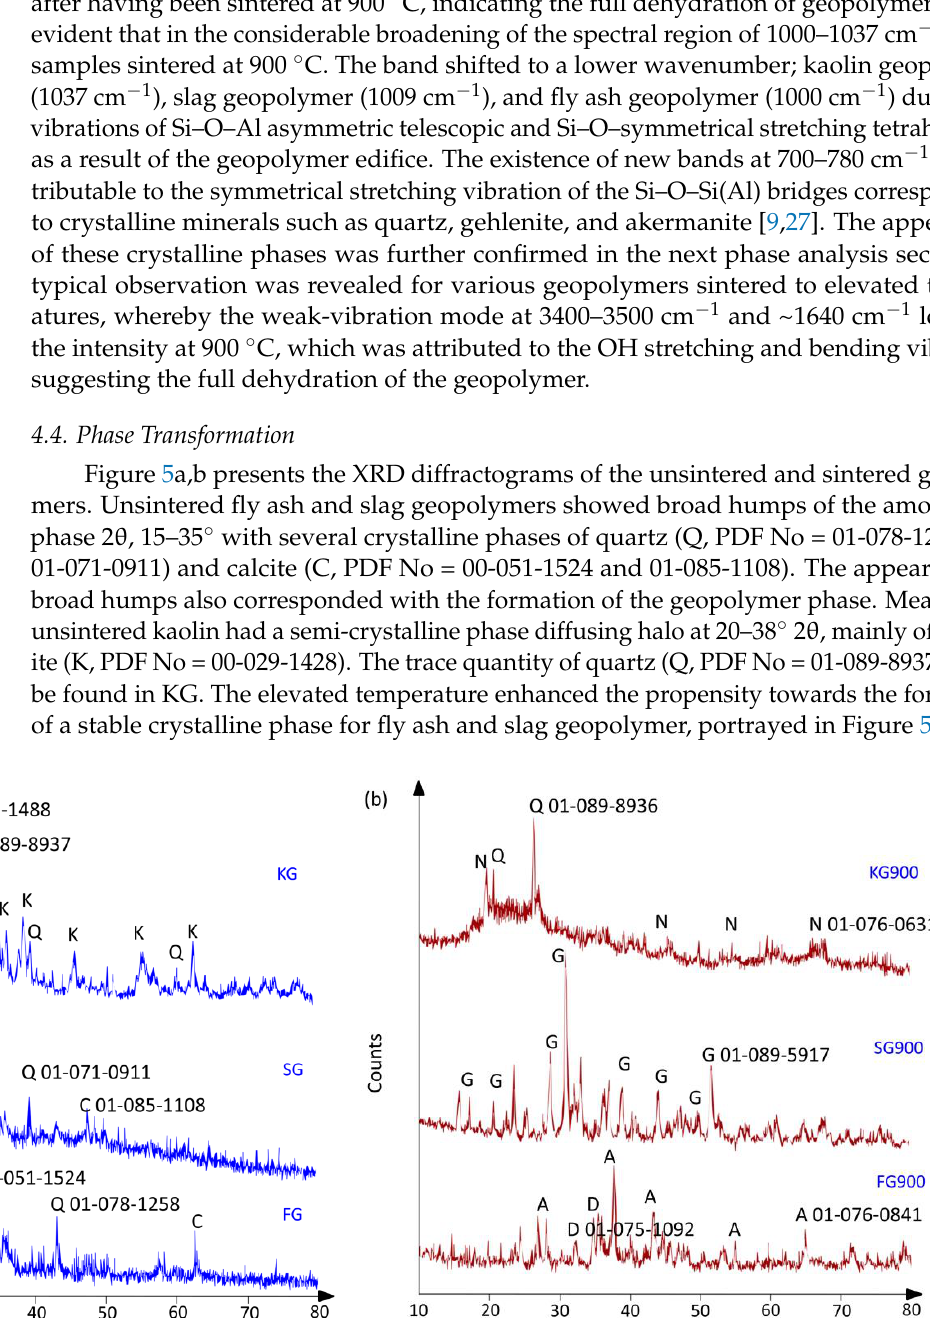
Figure 4. Fourier-transform infrared spectroscopy (FTIR) of the ( a ) unsintered and ( b ) sintered geopolymer at 900 °C.